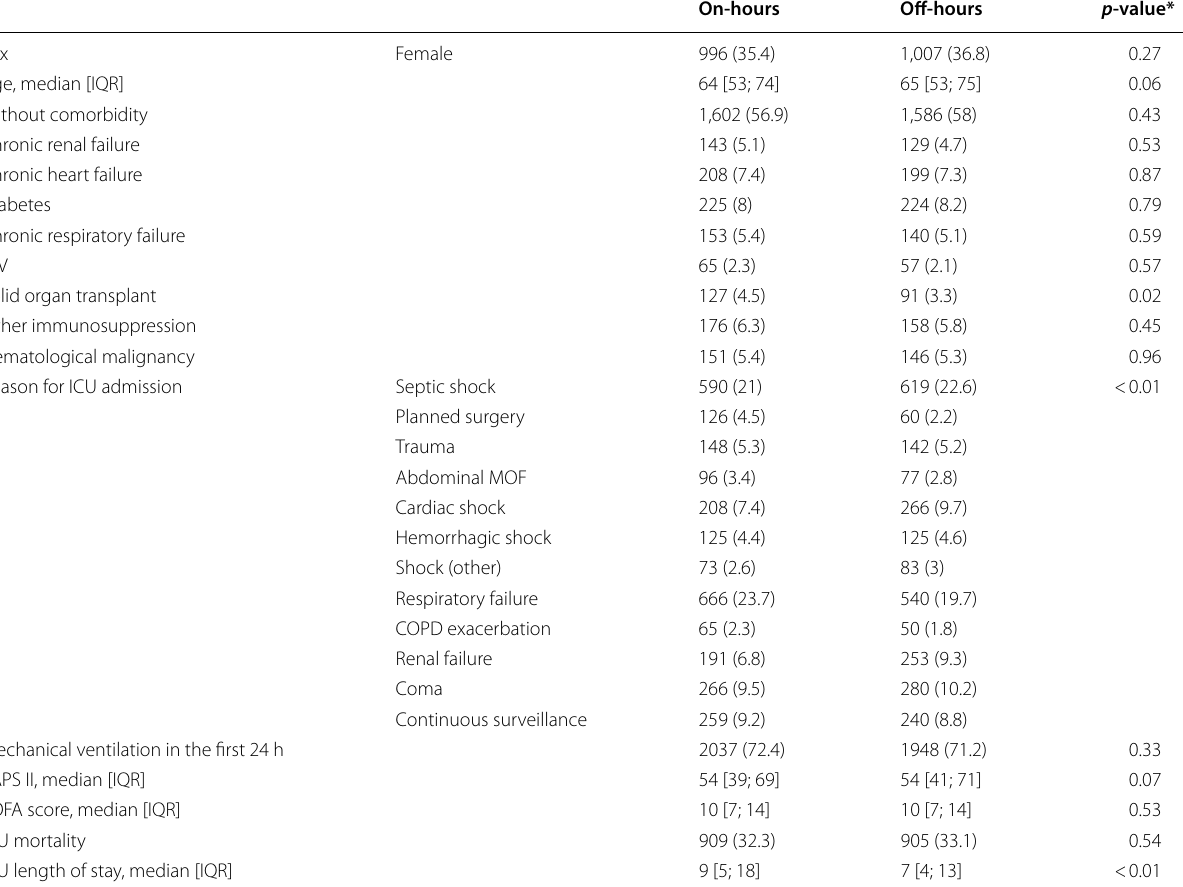
Table 1 Patients characteristics ( n